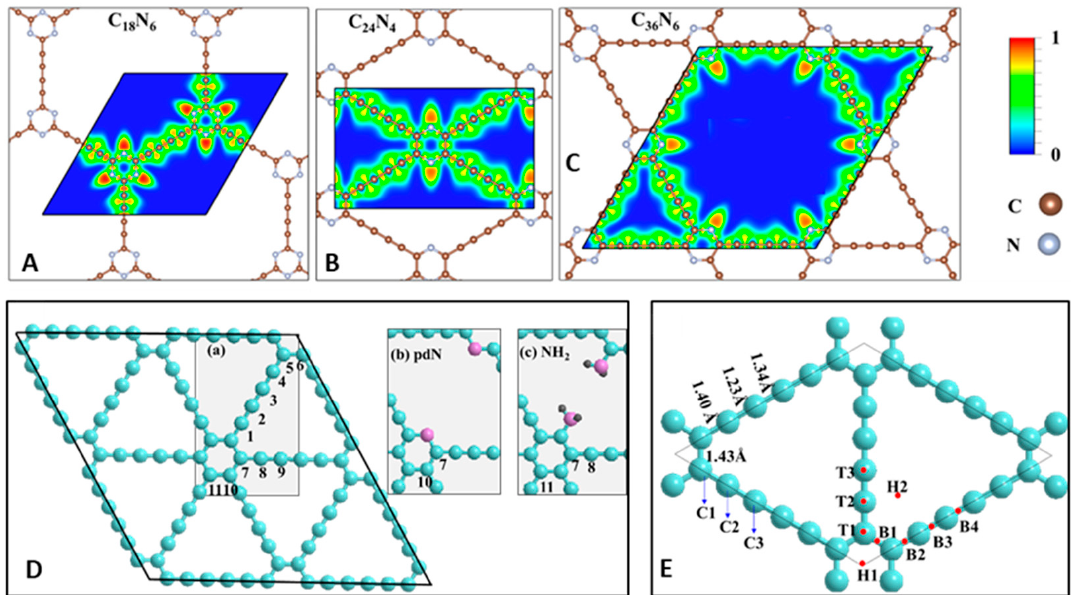
Figure 14. N-graphdiyne nanosheets unit cells of C 18 N 6 ( A ), C 24 N 4 ( B ), and C 36 N 6 ( C ). Reproduced with permission [144]. Copyright 2018, American Chemical Society. ( D ) The available position to be occupied by dopants (Da), pyridinic N- doped GDY (pdN) (Db), and amino-group-doped GDY (NH 2 ) (Dc). ( E ) Optimized H 2 and O 2 adsorption sites on pristine γ -graphdiyne. Redrawn [146,147].